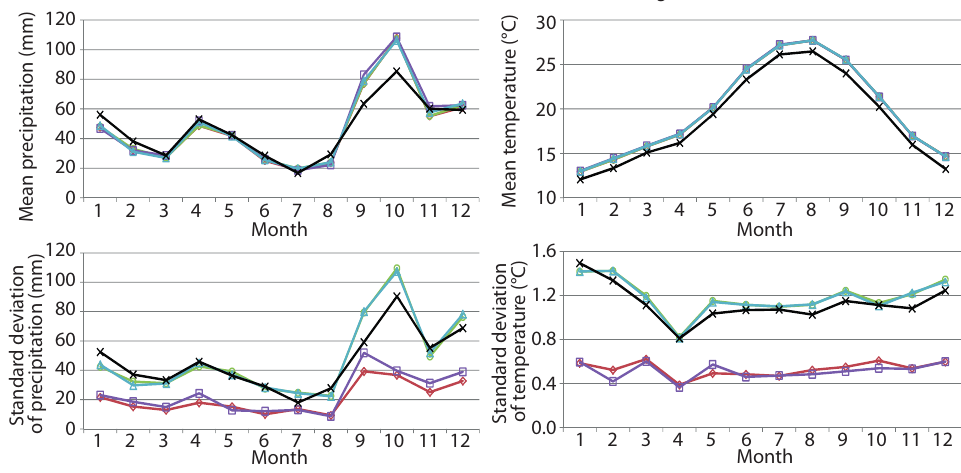
Figure 9. Monthly mean and standard deviation of future precipitation and temperature series obtained by the four ensemble options.